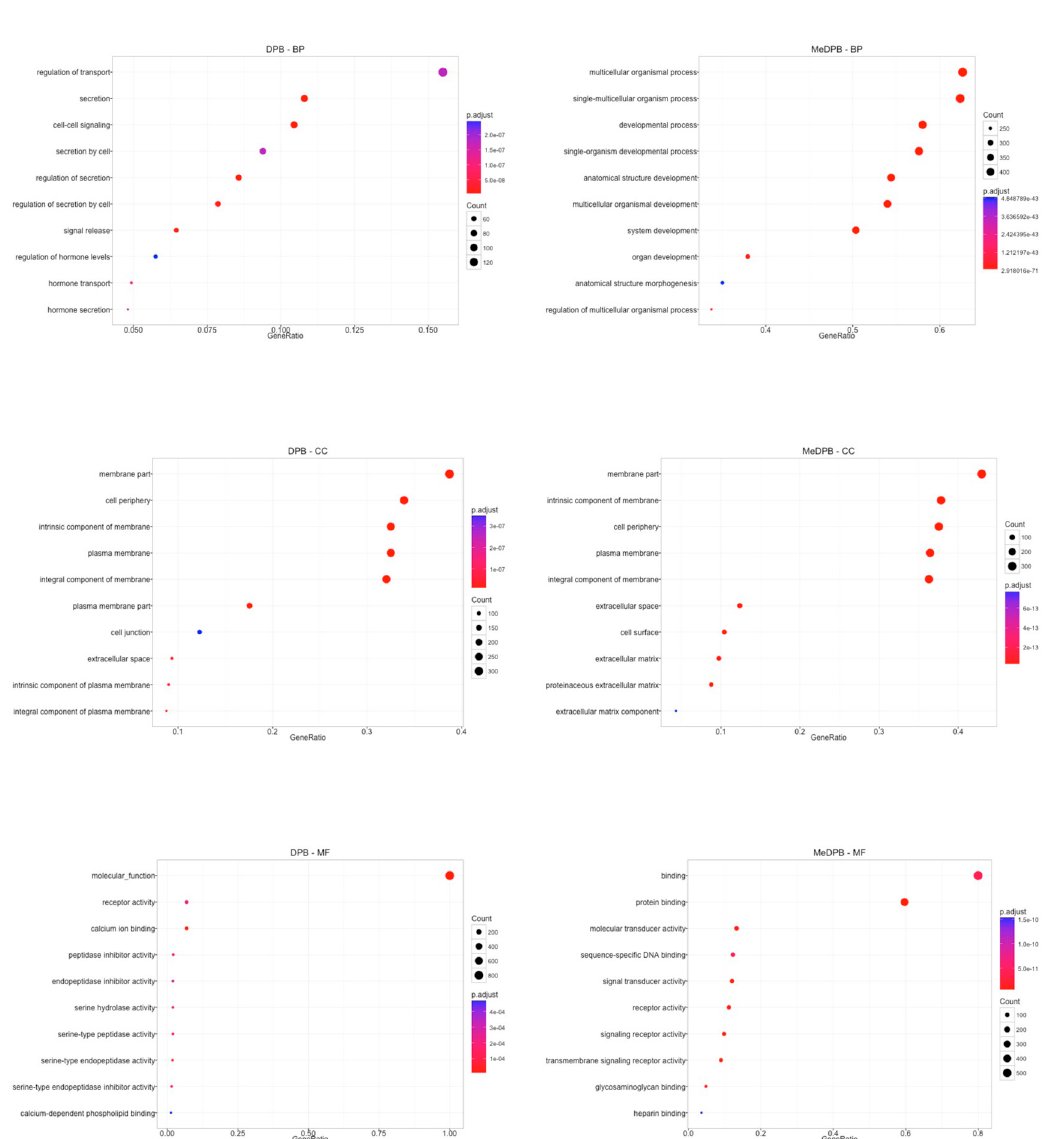
Figure 2. Gene Ontology analysis. The functional characterization of the specific gene expression profiles identified in the two compartments, DPB and MeDPB, was achieved by the annotation of differentially expressed genes with Gene Ontology (GO) terms including Biological Processes (BP), Cellular Components (CC), and Molecular Functions (MF). Over-representation test and False Discovery Rate (FDR) correction were performed to identify the most significantly enriched GO terms in DBP and MeDPB. In the dot plots, the top significant terms (defined as the ten with the lowest FDR- adjusted p -value) were reported on the y-axes, whereas gene ratio (defined as the fraction of overlapping genes) were indicated on the x-axes. Gene count (defined as the number of overlapping genes) and FDR-adjusted p -value were also represented in the plots by dot size and color, respectively. 2.2. In Vitro and In Vivo Characterization of Enriched Intrinsic Factors To identify DPB- and MeDPB-specific markers, we further analyzed the differentially expressed genes based on their Expressed Sequence Tag (EST) profile of these candidates [23]. We chose genes that showed an annotated expression in adult pancreas or during embryogenesis and that were poorly distributed in other compartments or developmental stages (data not shown). Among all 51 enriched genes in DPB, we selected 5 genes: Frem2 (Fras1-related extracellular matrix protein 2),